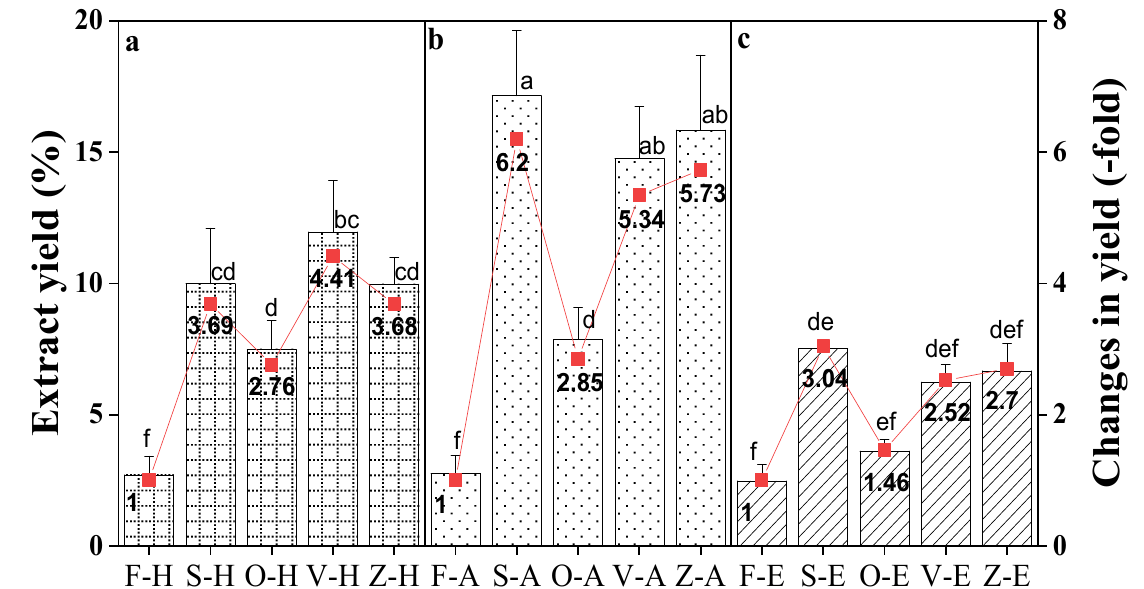
Figure 1. Extraction yield of Bentong ginger extracted using ( a ) hot water (H), ( b ) aqueous (A), and ( c ) ethanol (E) solvents via sun (S)-, oven (O)-, vacuum (V)- and freeze (Z)-drying methods. Fresh ginger (F) was used as the control. Changes were calculated based on the respective fresh ginger samples. Bars with different letters are significantly different. Sample F-H = Fresh ginger (Control) with hot water, and sample Z-E is freeze-drying with ethanol.